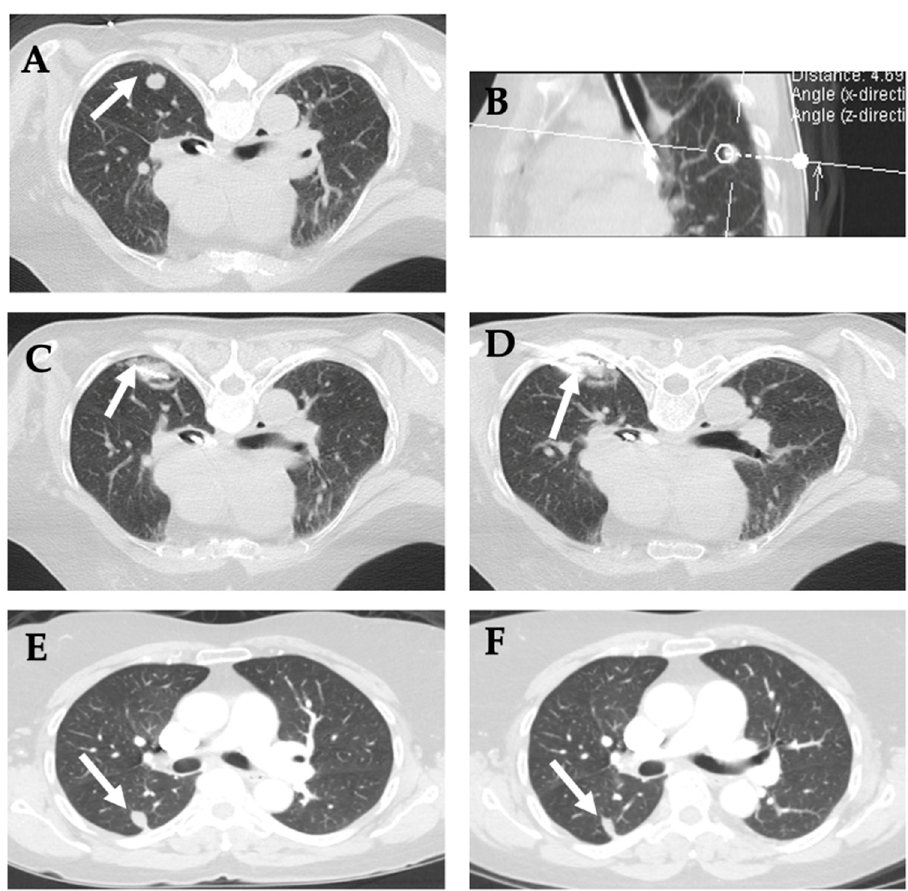
Figure 16. Cryoablation of right lower lobe lung metastatic lesion suspected for colorectal cancer metastasis . ( A , B ) CT images of the chest show the 1.2 cm nodule (white arrow) in the right lower lobe of the lung. ( C ) Under CT image-guidance, two Endocare PCS-17R cryoablation probes were advanced via a posterior approach, which bracketed the tumor to optimize the ablation coverage of the lesion. ( D ) Under CT image-guidance, a 19-gauge needle was advanced down to the lesion. An image was obtained and placed into the medical record. Samples were obtained for evaluation. Cryoablation was performed with three freeze cycles that lasted three, seven, and ten minutes, respectively, interposed with three minutes passive thaw cycles. ( E ) 6 and ( F ) 12-month follow up images show shrinking scar.